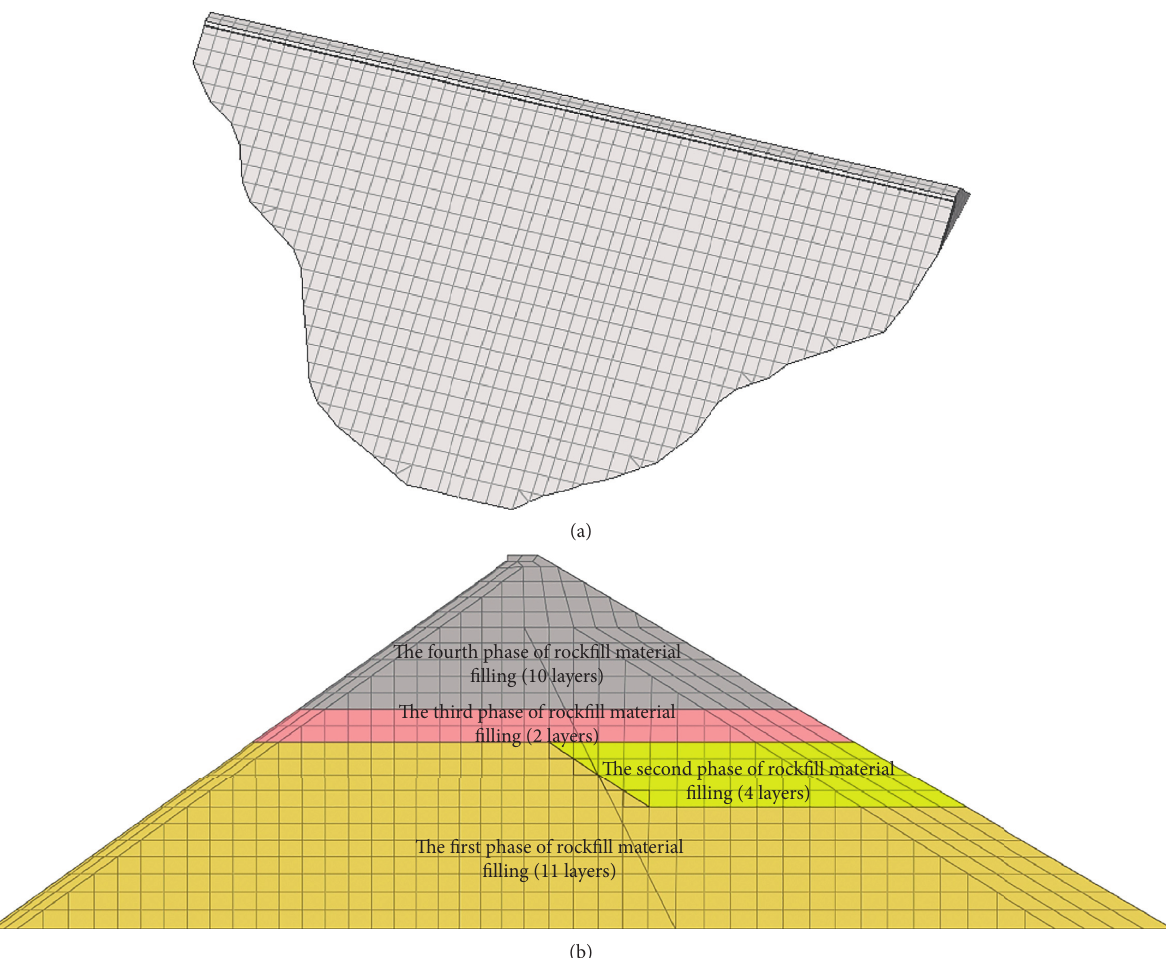
Figure 4: The model of the Xujixia CFRD. (a) Three-dimensional finite element grid. (b) Standard cross section finite element